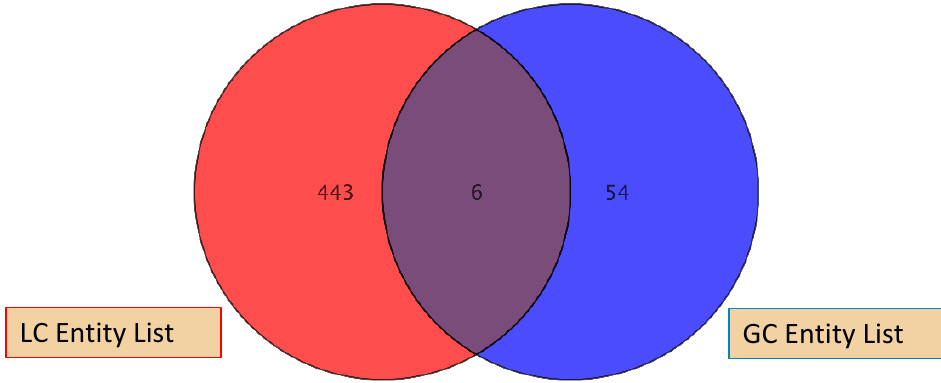
Figure 9. Compounds identified usingLC/Q-TOF and GC/Q-TOF analyses.